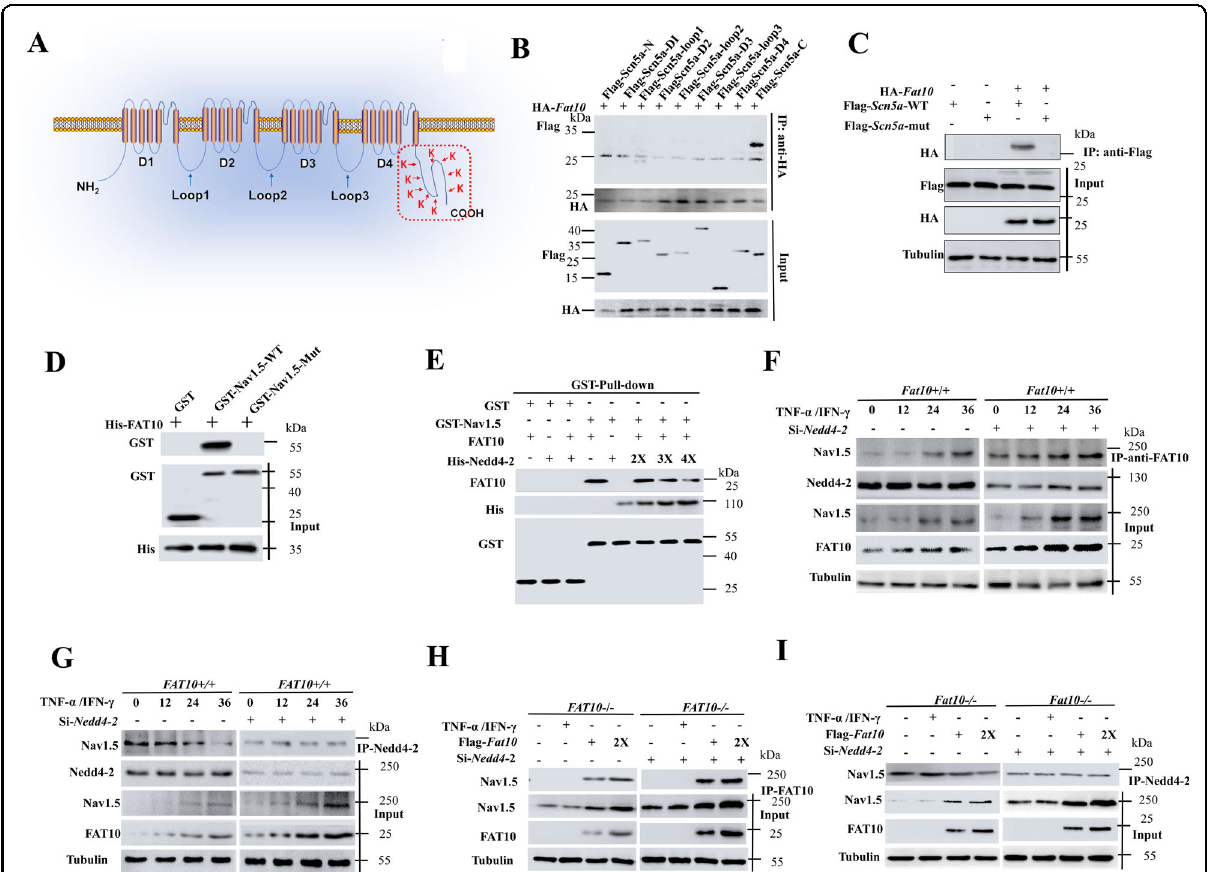
Fig. 6 FAT10 antagonizes Nav1.5 ubiquitination by competing with Nedd4-2. A Schematic diagram of Nav1.5 deletions and mutants. B HEK293 cells were transfected with the indicated constructs and then lysed for the Co-IP assay using anti-Flag beads to detect HA-FAT10 binding. C Representative immunoblots of FAT10 binding with Nav1.5 in HEK293 cells co-transfected with HA-Fat10 and Flag-Scn5a wild-type or the Flag-Scn5a mutation plasmid as detected by Co-IP. D GST pull-down experiments were performed to assess the association between FAT10 and Nav1.5. E Competitive binding of Nav1.5 was analyzed in a GST pull-down experiment. F , G Fat10 + / + HEK293 cells were transfected with Si-Nedd4-2 or Si-scramble and treated with IFN- γ /TNF- α for the indicated times. Co-IP was performed to detect Nedd4-2 – Nav1.5 and FAT10 – Nav1.5 complex formation. H , I Fat10 − / − HEK293 cells were transfected with Si-Nedd4-2/Si-scramble and the Flag-Fat10 plasmid. Co-IP was performed to detect Nedd4-2 – Nav1.5 and FAT10 – Nav1.5 complex formation. HEK293 cells were treated with IFN- γ /TNF- α to induce FAT10 expression. All results are expressed as the mean ± SEM of independent